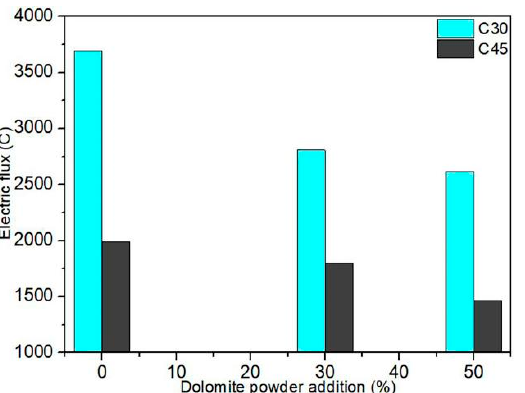
Figure 3. The relationship between the electric flux of concrete and dolomite powder dosage.